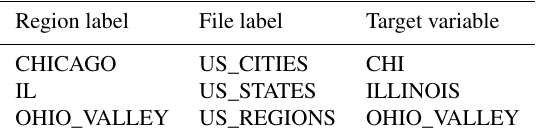
Table 4. Example entries for the Region definition